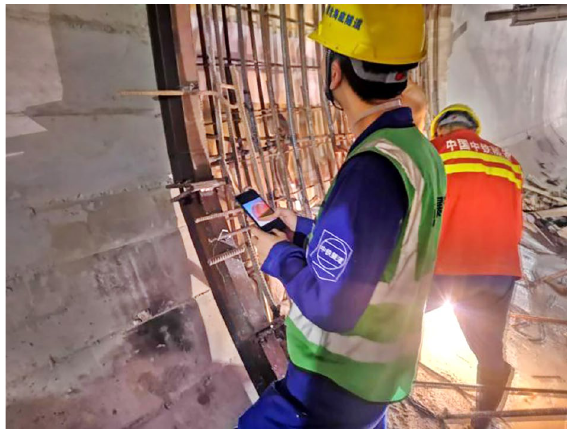
Figure 9. The worker on site is conducting a technological ex- planation according to the BIM 3D model displayed on